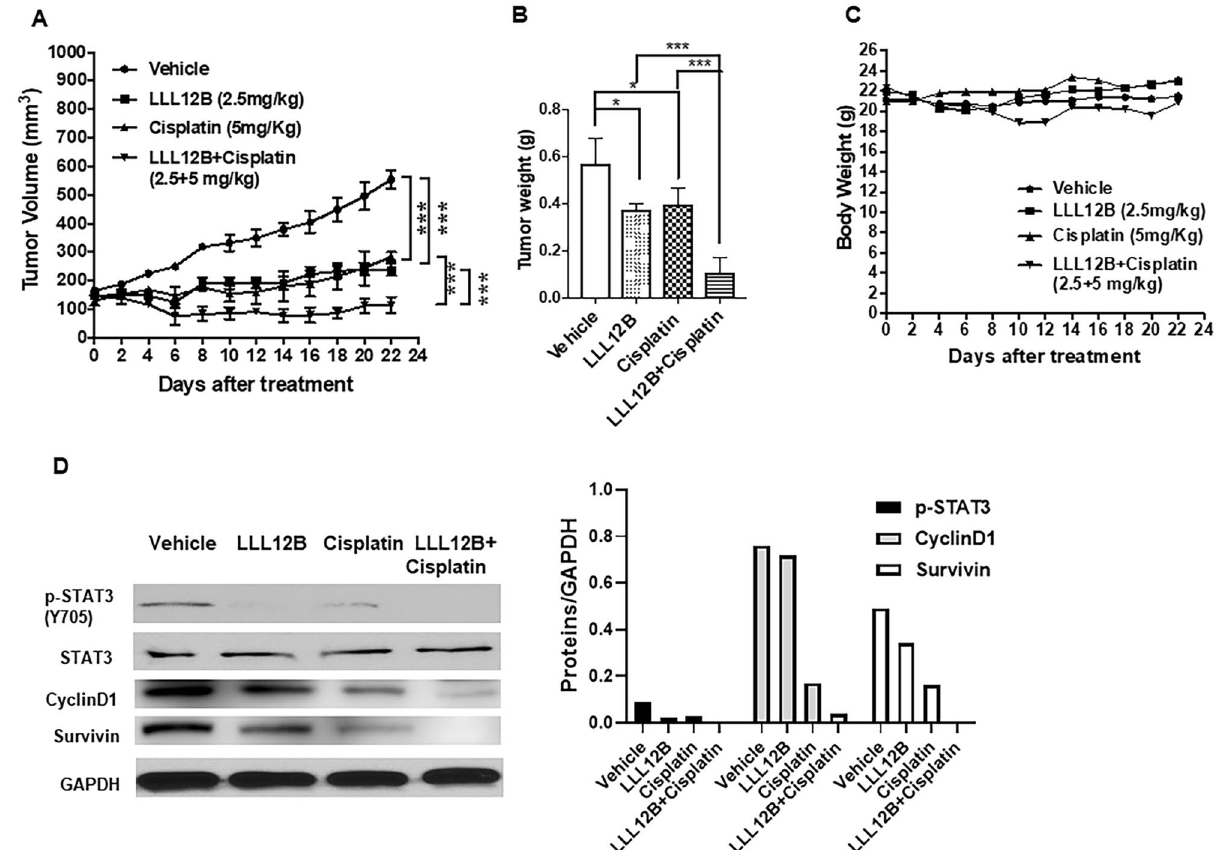
Figure 10. Anti-neoplastic activity of LLL12B and cisplatin combined treatment of D425 medulloblastoma xenografts. ( A ) Tumor volumes. ( B ) Tumor weights. ( C ) Body weights. ( D ) Protein analysis of the representative tumor samples by western blots. Expression levels of p-STAT3 (Y705), STAT3, CyclinD1, Survivin, and GAPDH. D245 medulloblastoma cells (1 × 10 7 cells/tumor) were implanted subcutaneously into the flank region of 4 to 5 week-old female athymic nude mice. Mice were randomized into four groups (5 mice for each group) and treated with LLL12B (2.5 mg/kg, oral gavage, once daily) and/or cisplatin (5 mg/kg, intraperitoneal injection, once every 4 days) or vehicle